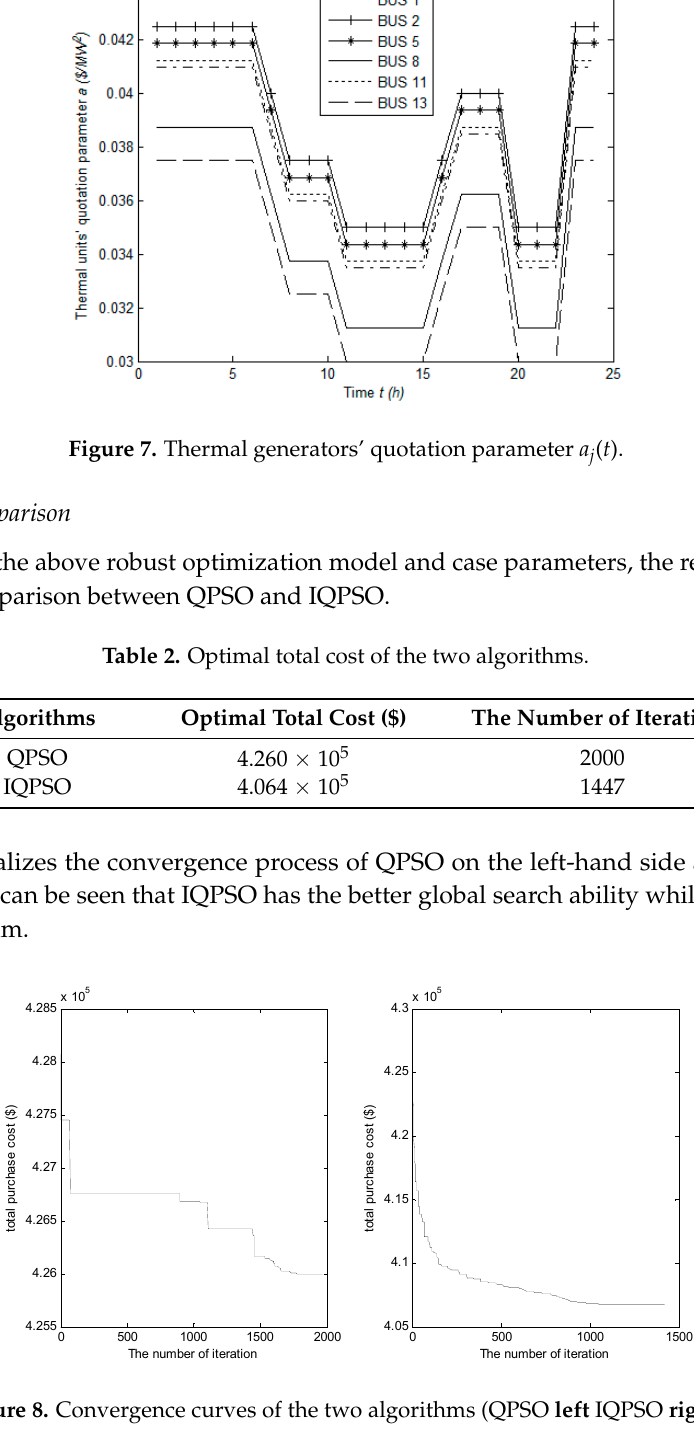
Figure 8. Convergence curves of the two algorithms (QPSO left IQPSO right )